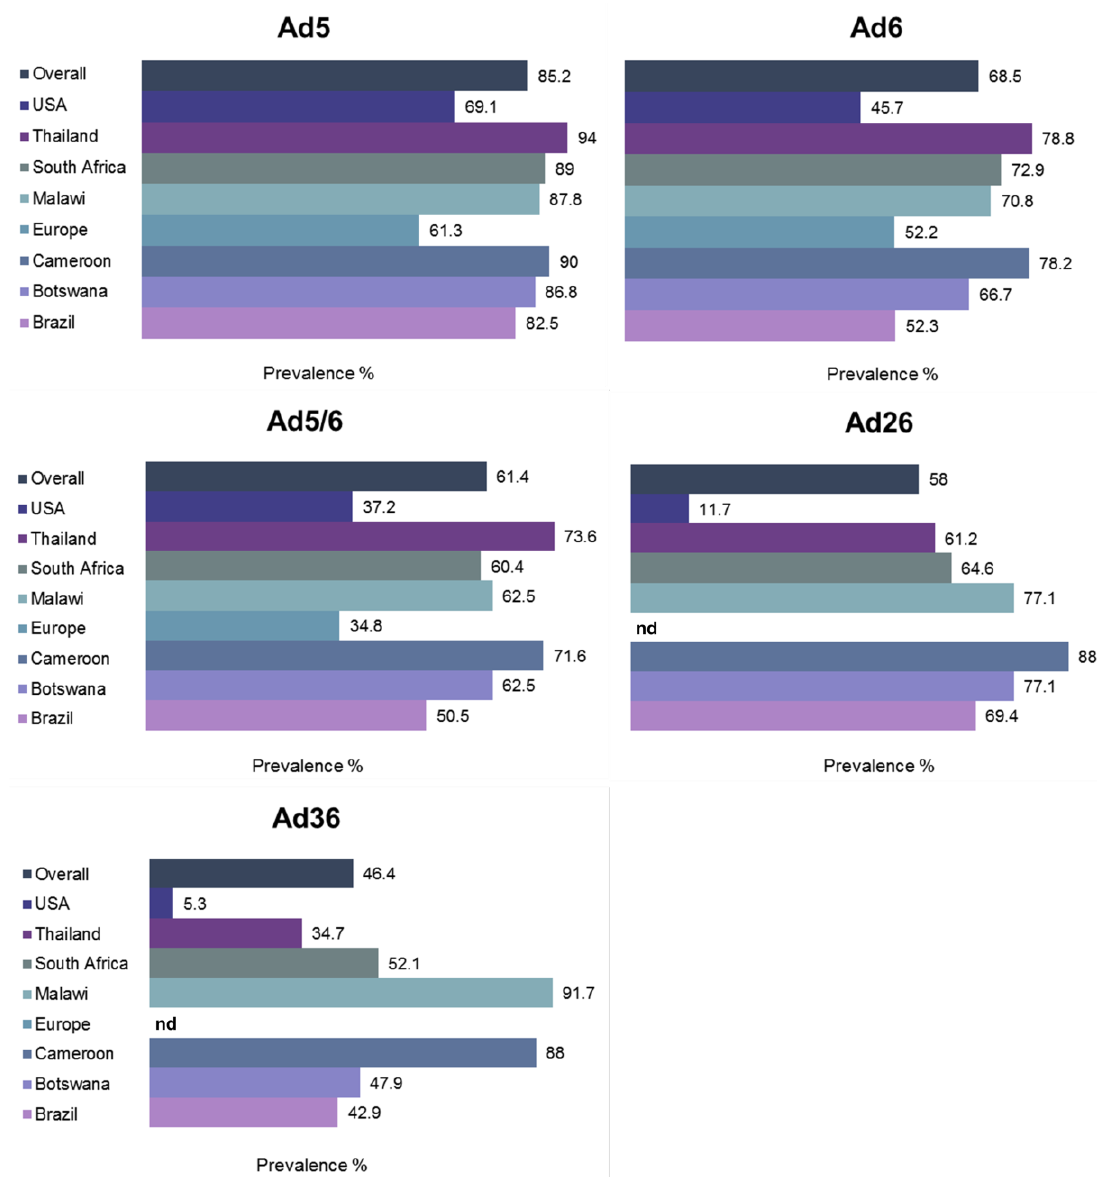
Figure 5. Global prevalence of neutralizing antibodies (nAbs). nAb titers against five different Ad viruses from subgroups C (Ad5, Ad6] and D (Ad26, Ad36] were determined from ~1900 individuals at 34 different locations in South America, Africa, Asia, Europe and United States. nd, not determined. Adapted from [12].